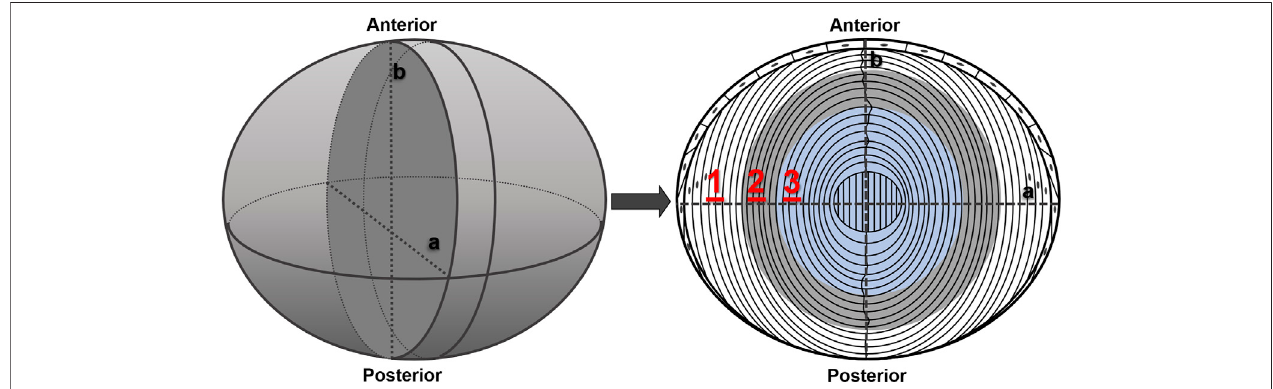
FIGURE1| Schematicgraphoflenssectionwithdifferentscanningregions.Theleftplotdemonstratesthewholelensafterdissection,andtherightplotdepictsthe anterior – posterior(A/P)sectionofthelenscutasscanningsample.Indexlines(aandb)showtheorientationoftheslice.1,2,and3inredrepresentsscanningregions1, 2, and 3 (20 μ m in length for